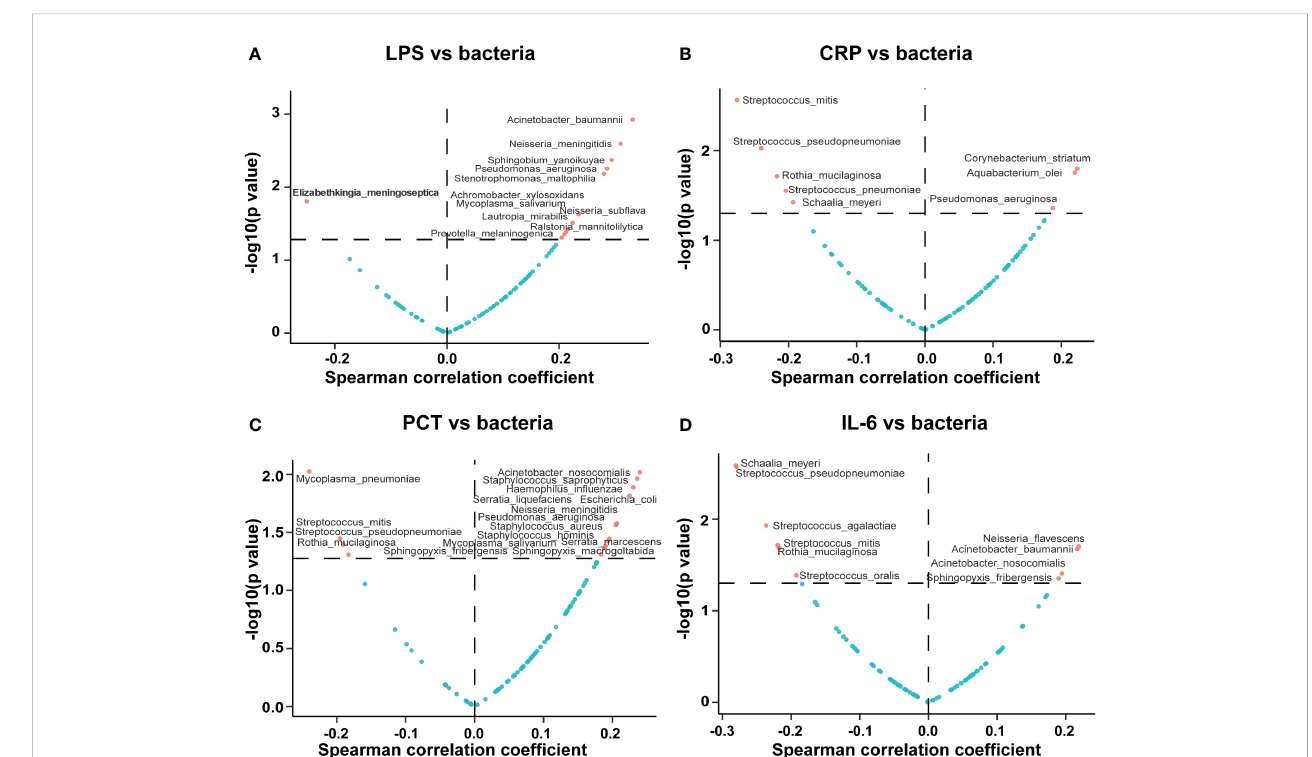
FIGURE 3 Correlations of potentially pathogenic bacteria in BALF with serum in fl ammatory indicators. The volcano plot displays the correlations of the potentially pathogenic bacteria in BALF with the serum (A) LPS, (B) CRP, (C) PCT, and (D) IL-6 concentrations. The horizontal coordinate represents the Spearman correlation coef fi cient, and the vertical coordinate represents the negative logarithm of the p-value of the correlation between the clinical phenotype and potential pathogen; i.e., − log10 (p value). Each point in the graph represents a potentially pathogenic microorganism, and those screened for signi fi cant differences have been marked in